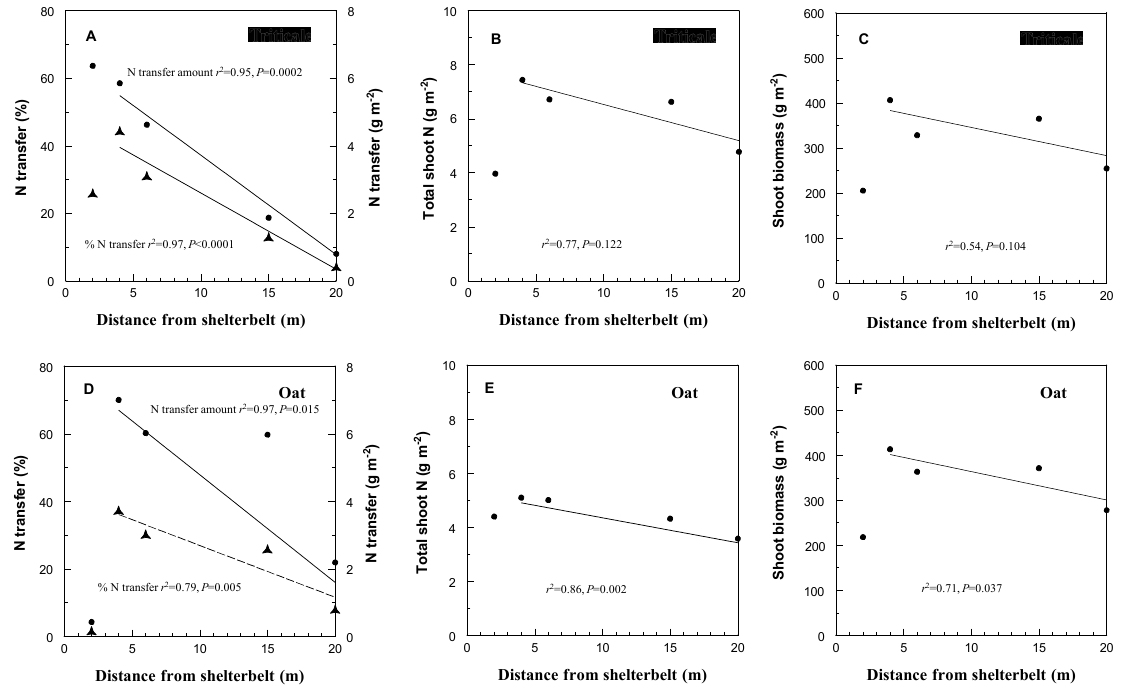
Figure 2. Nitrogen transfer characteristics and above-ground productivity in triticale ( A – C ) and oat ( D – F ) as a function of perpendicular distance away from a caragana shelterbelt. ( A , D ) are percentage of N in the forage crops transferred (dots) from caragana and amount of N transferred (triangles); ( B , E ) are total N in the above-ground biomass and ( C , F ) are above-ground